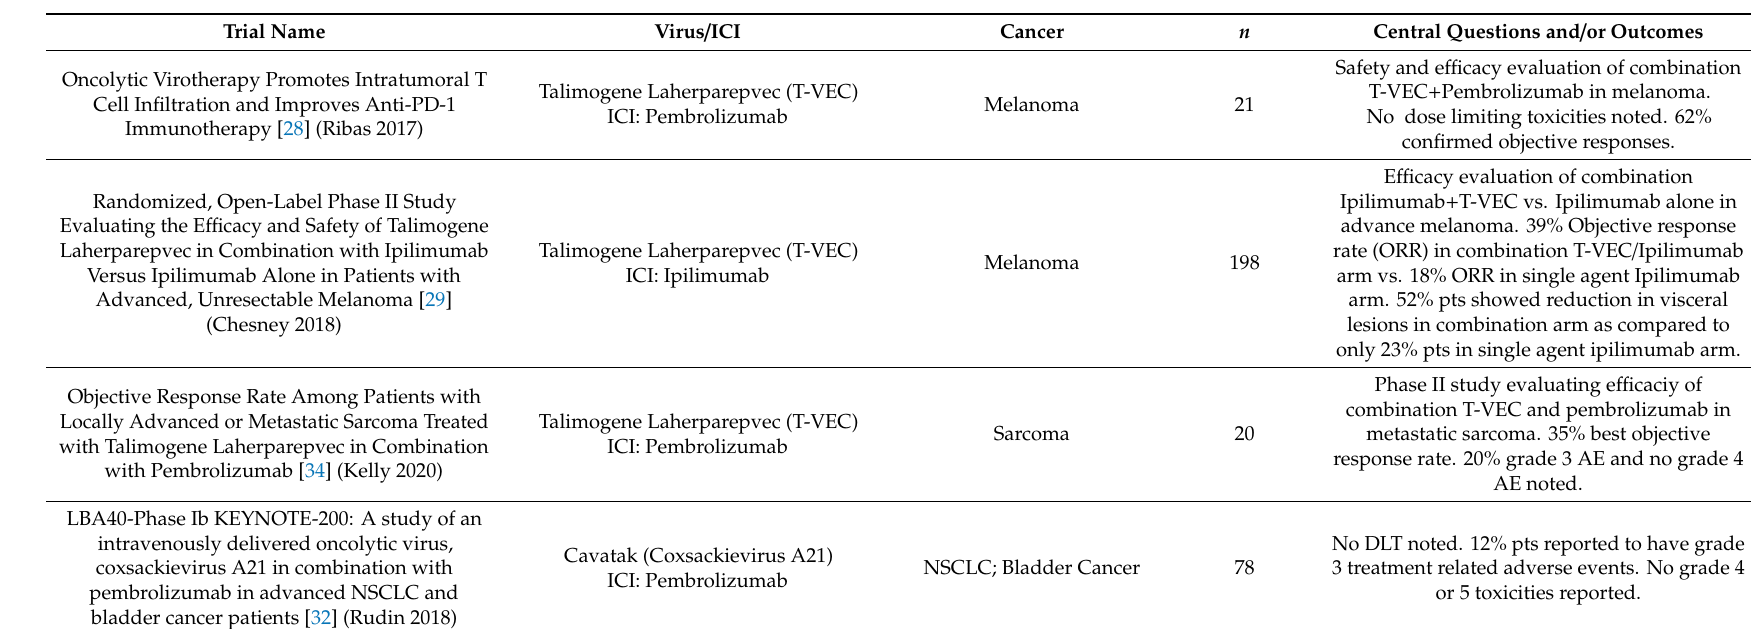
Table 1. Summary of combination oncolytic virus and immune checkpoint inhibitor (ici) clinical